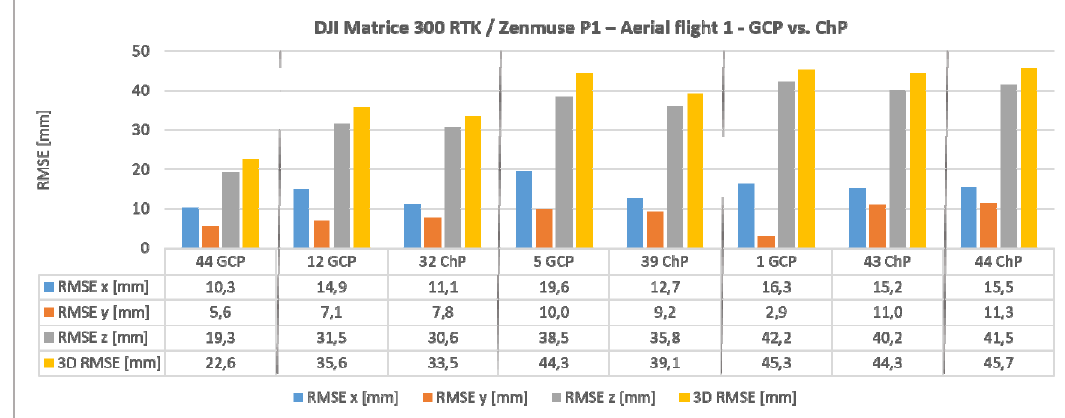
Figure 5 . Results of bundle block adjustments with different control and check point versions for UAV flight 1 using Zenmuse P1 camera.